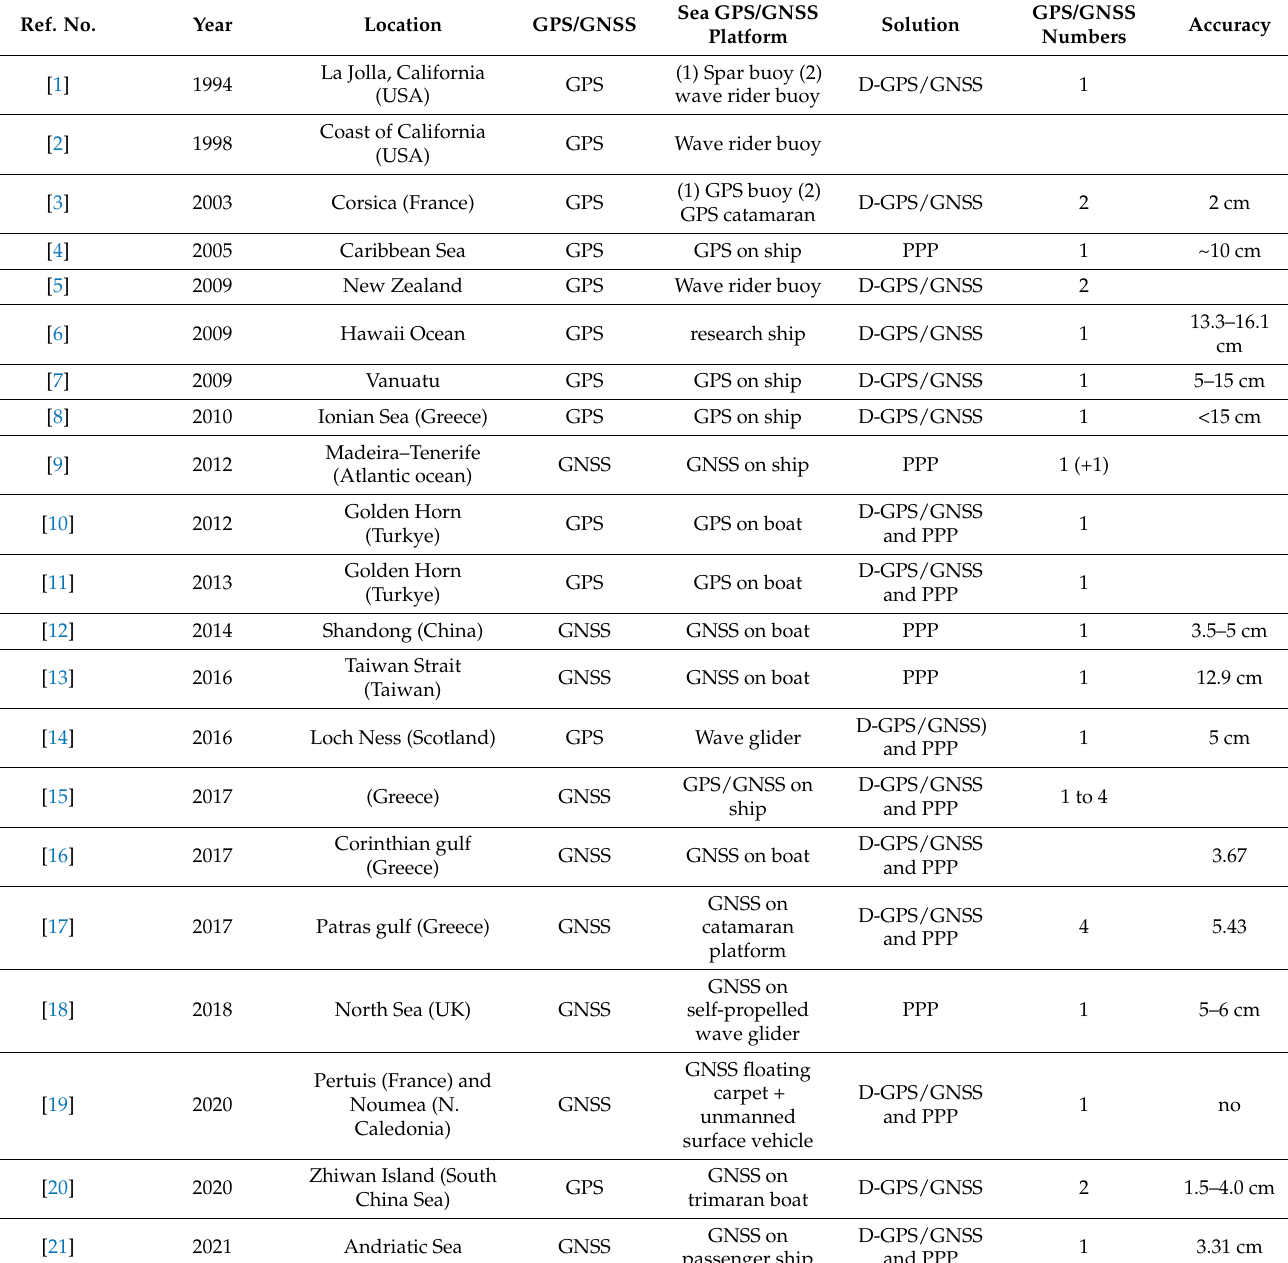
Table 1. Illustrates the main characteristics of the works dealing with the application of the “GPS/GNSS on boat” technique in determining the sea surface topography and geoid. Ref.